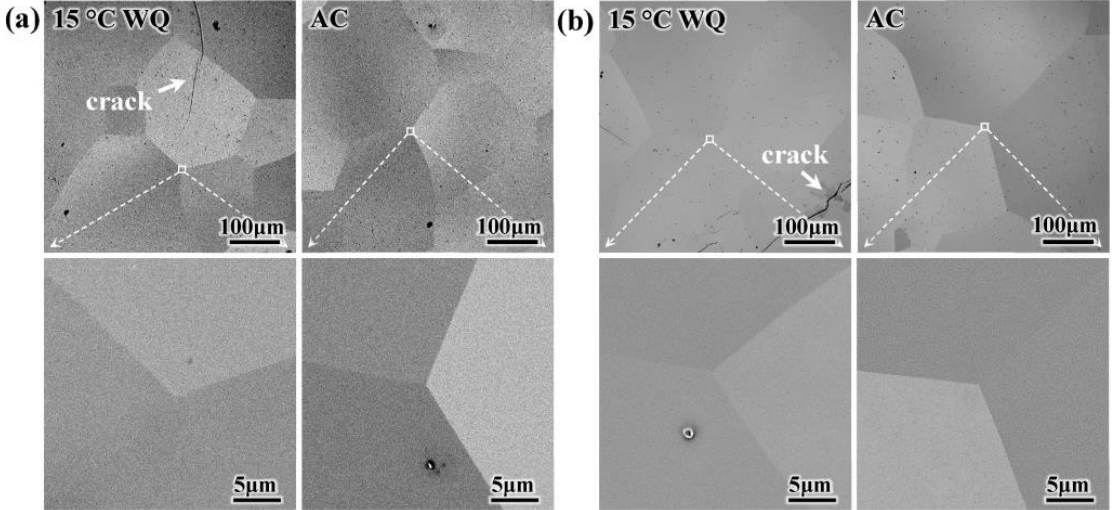
Figure 1. SEM micrographs of solution-treated 6Ni2Mo ( a ) and 8Ni2Mo ( b ) alloys subjected to 15 °C water quenching (WQ) or air cooling (AC). The magnified images show clean grain boundaries without γ phase .